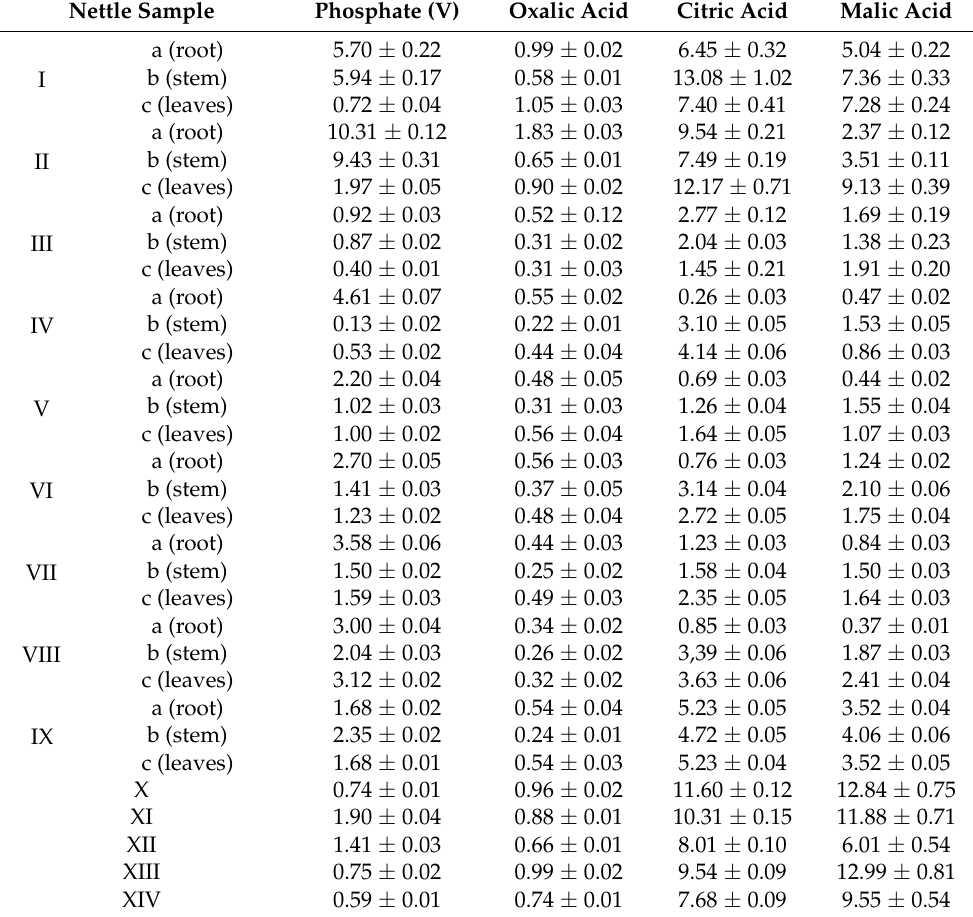
Table 3. Phosphate (V) and organic acid contents of nettle determined with capillary isotachophoresis (mg g − 1 of fresh weight); samples I–IX: a—root; b—stem; c—leaves; X–XIV—aerial parts of